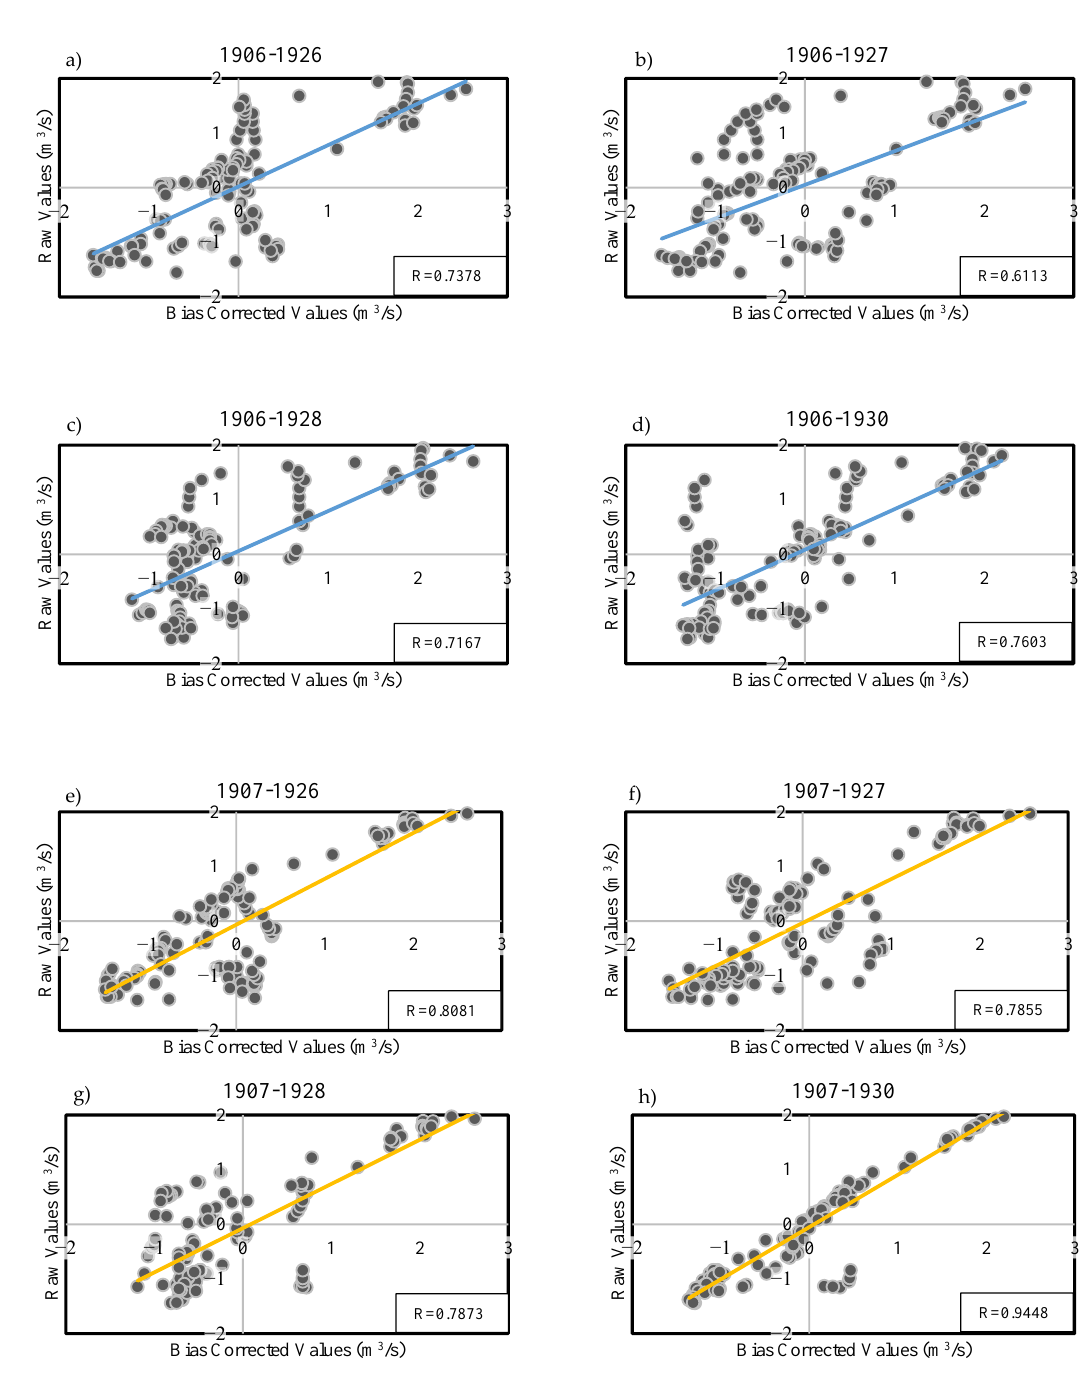
Figure 12. Raw and bias-corrected SDI values comparison. ( a ) 1926 and 1906, ( b ) 1927 and 1906, ( c ) 1928 and 1906, ( d ) 1930 and 1906, ( e ) 1926 and 1907, ( f )1927 and 1907, ( g ) 1928 and 1907, ( h ) 1930 and 1907. Linear regression line represented with yellow line.